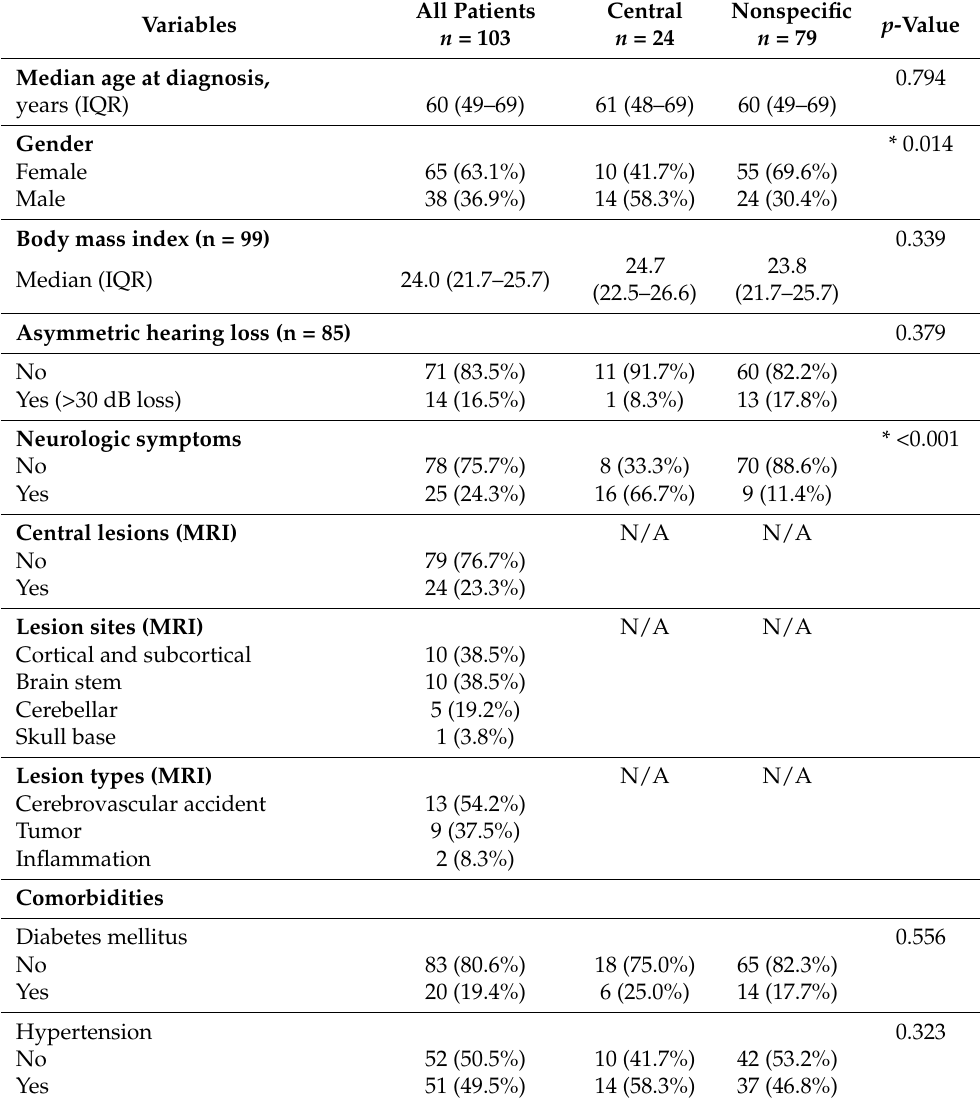
Table 1. Demographic and clinical characteristics of the 103 vertigo patients included in the